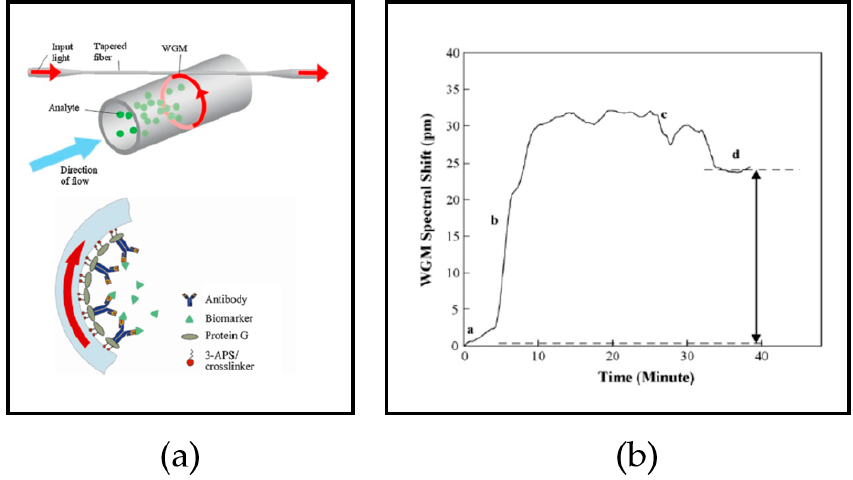
Figure 9. Analysis of HER2 biomarker. ( a ) OFRR schematic. The cross-section diagram visualizes the layer of the OFRR inner core surface; ( b ) spectral shift at (a) buffer flow, (b) sample flow, (c) sample binding and (d) buffer washes. Reprinted with permission from [138]. Table 4. Comparison of LOD, analysis time, and label of various methods